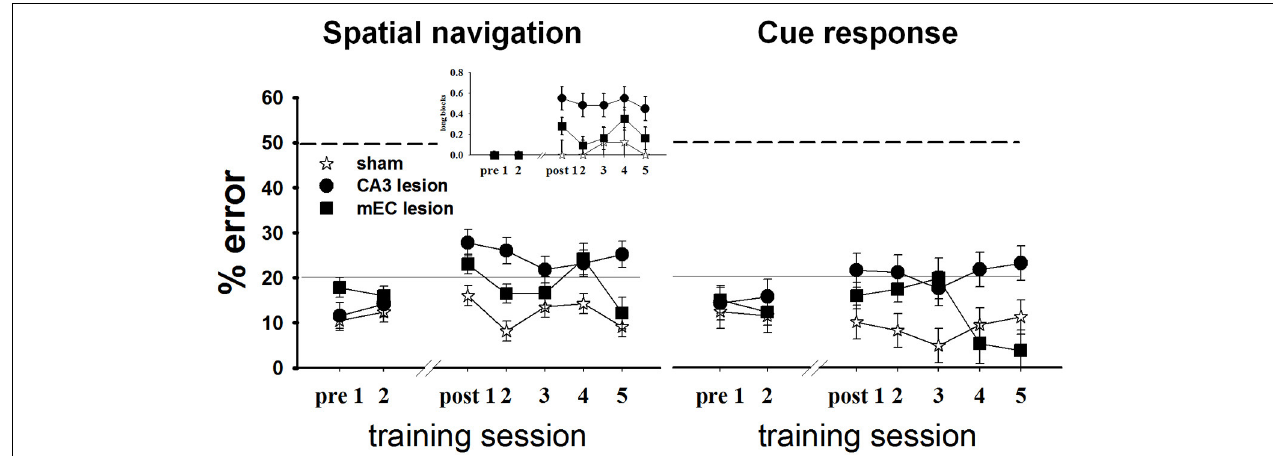
FIGURE 5 | CA3 and MEC are involved in supporting spatial navigation and cue approach performance. Retention testing comprised all rats for 2 days ( n = 4 TC, 5 CA3, and 6 MEC rats), and extended to 5 days for a subgroup ( n = 4 TC, 5 CA3, and 2 MEC rats). In the spatial task (left), the performance of CA3 and MEC lesioned animals was impaired by comparison to their own pre-lesion levels, and to post-lesion level of TC group. Training reduced the behavioral deficit of the MEC lesion group but not of the CA3 lesion group. The more